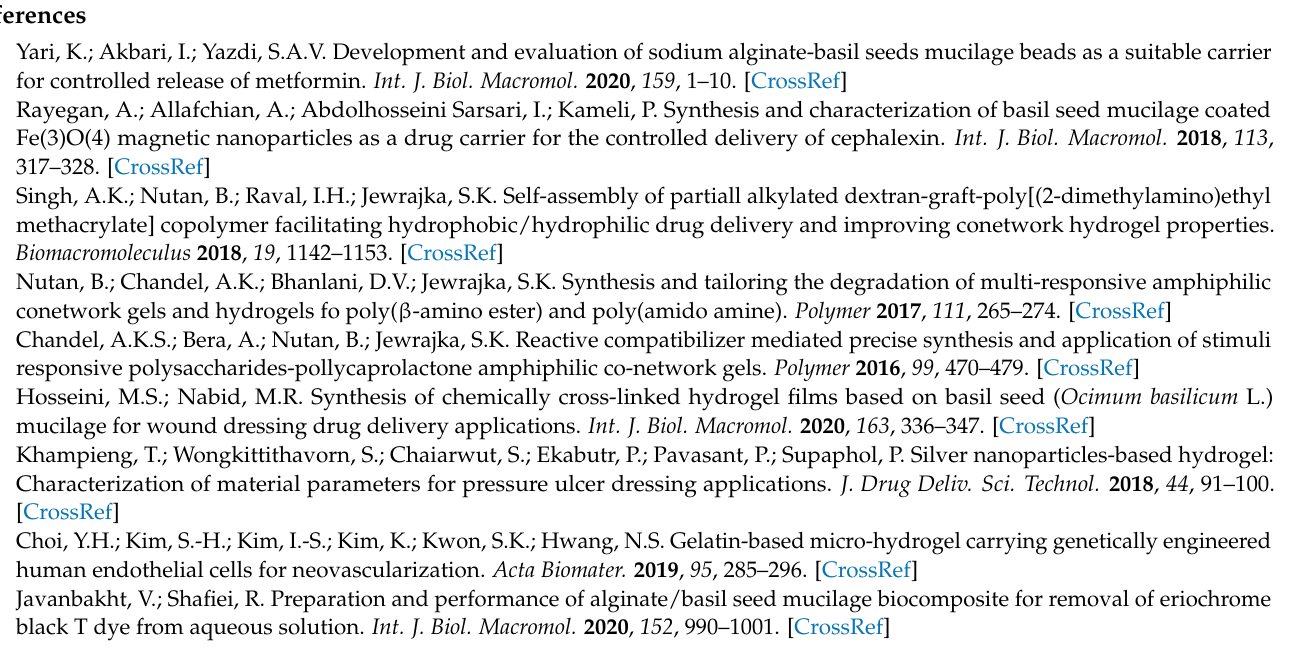
preparation; Table S1. The properties for Grey relational coefficient calculation for the L16 compara- bility sequences; Table S2. Sol fraction of the hydrogel beads; Figure S1 shows the release profiles obtained using the four mathematical